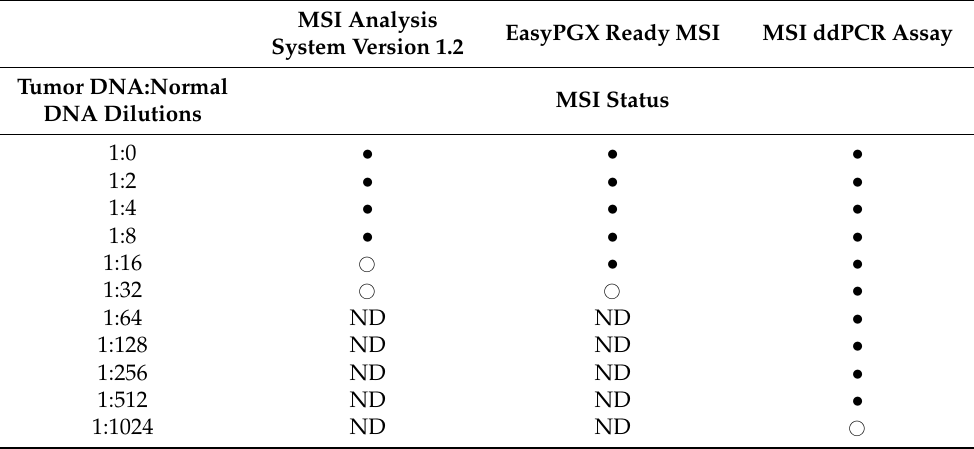
Table 2. Comparison of MSI detectability in the three commercial kit at the different tumor DNA/Normal DNA